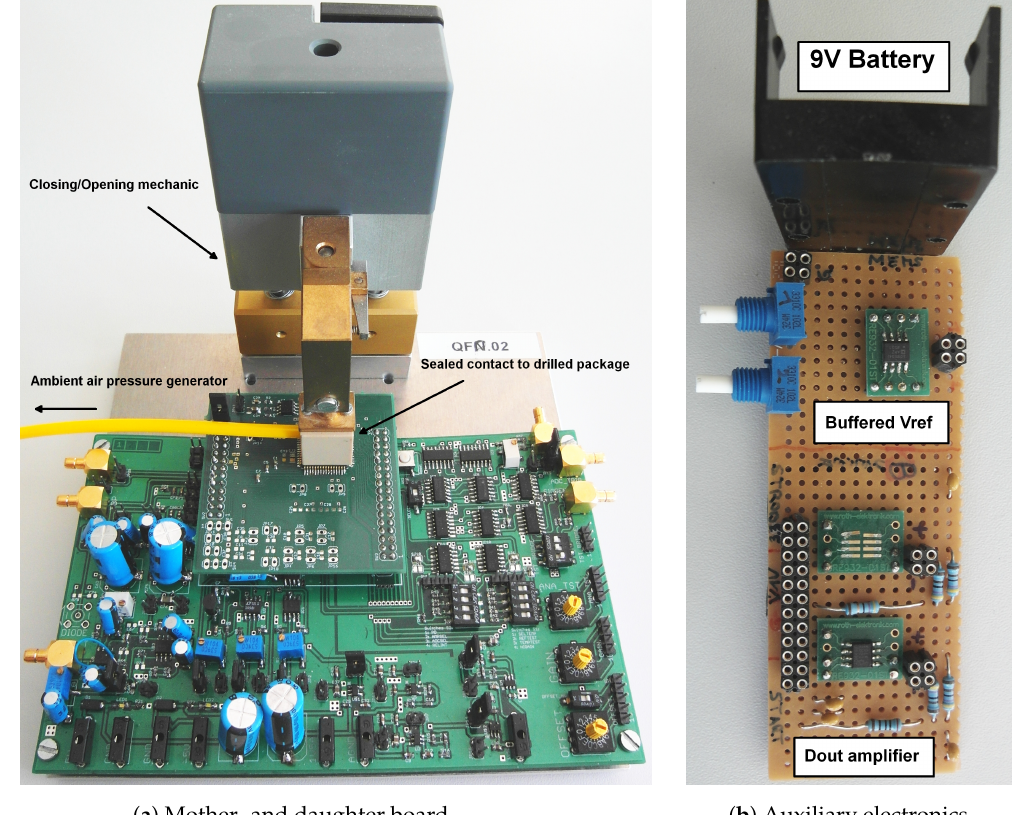
Figure 12. Motherboard attached to a daughter board with a real pressure sensor test chip docked to the ambient air pressure generator via pneumatic mechanics ( a ); an external reference generator (1.5 V from a 9 V block battery) buffer AD8034 and auxiliary digital output amplifier buffer ADN466 ( b